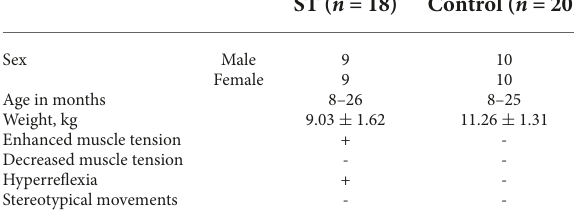
TABLE 1 Clinical characteristics of our